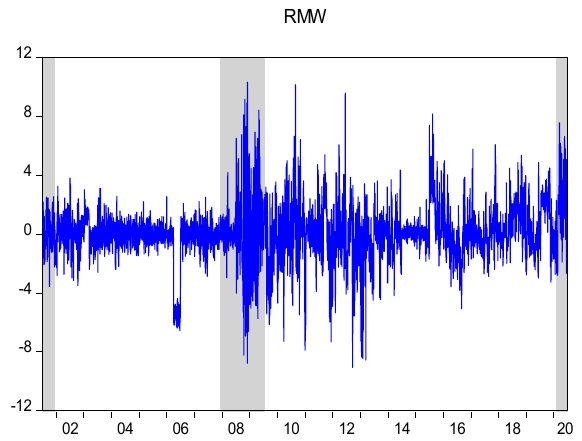
Figure 3. Time series variation in RMW premiums.